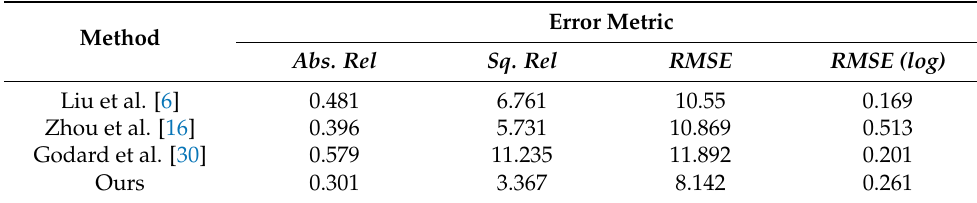
Figure 5. Depth estimation from the unsupervised methods of Zhou et al. [16] and ours on the Make3D dataset. Table 4. Results of different methods on the Make3D dataset